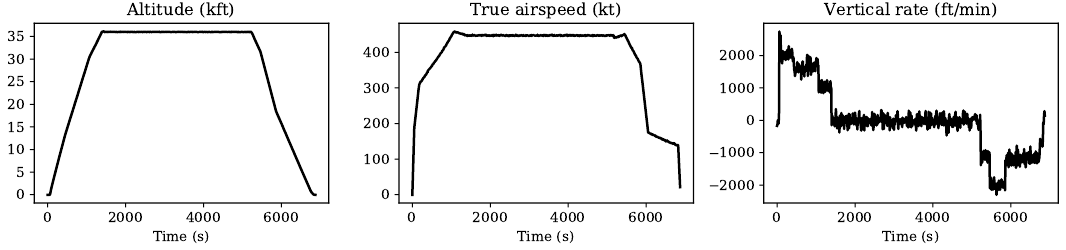
Figure 9. Generated complete trajectory with noise added (Airbus A320).